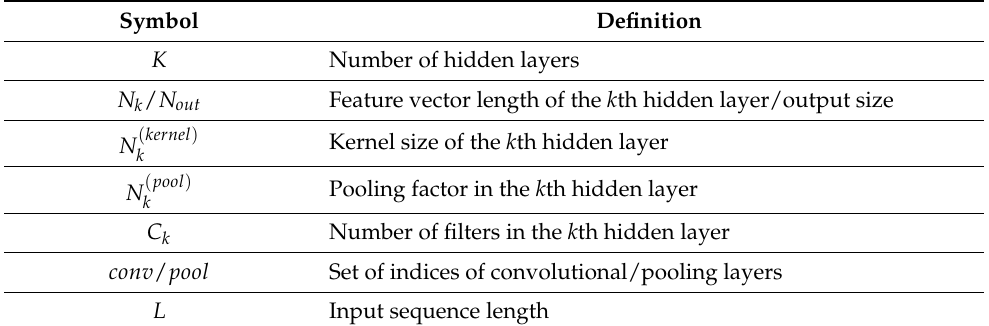
Table 3. Notation of equations indicating model complexity.